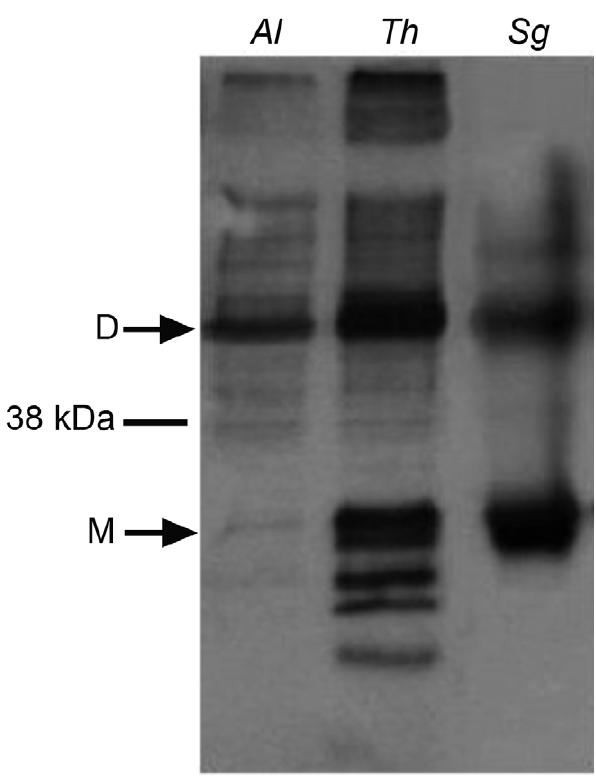
Figure 4. Western blots of the membrane preparations from C41 E. coli strains expressing microsporidian AOX proteins. Lane 1 shows A. locustae rAOX and Lane 2 shows T. hominis rAOX. Lane 3 shows purified alternative oxidase protein from Sauromatum